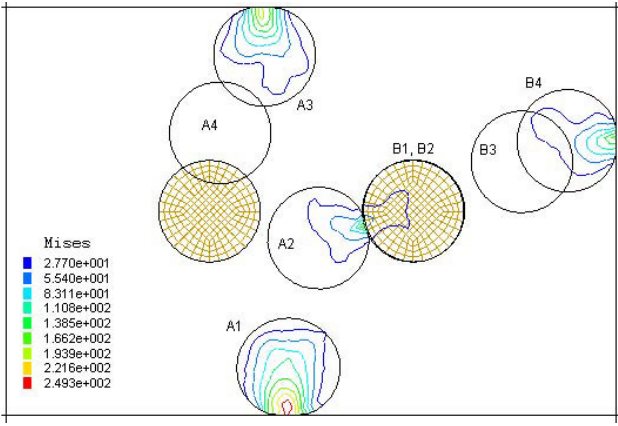
Fig. 3. Energy evolution vs time.